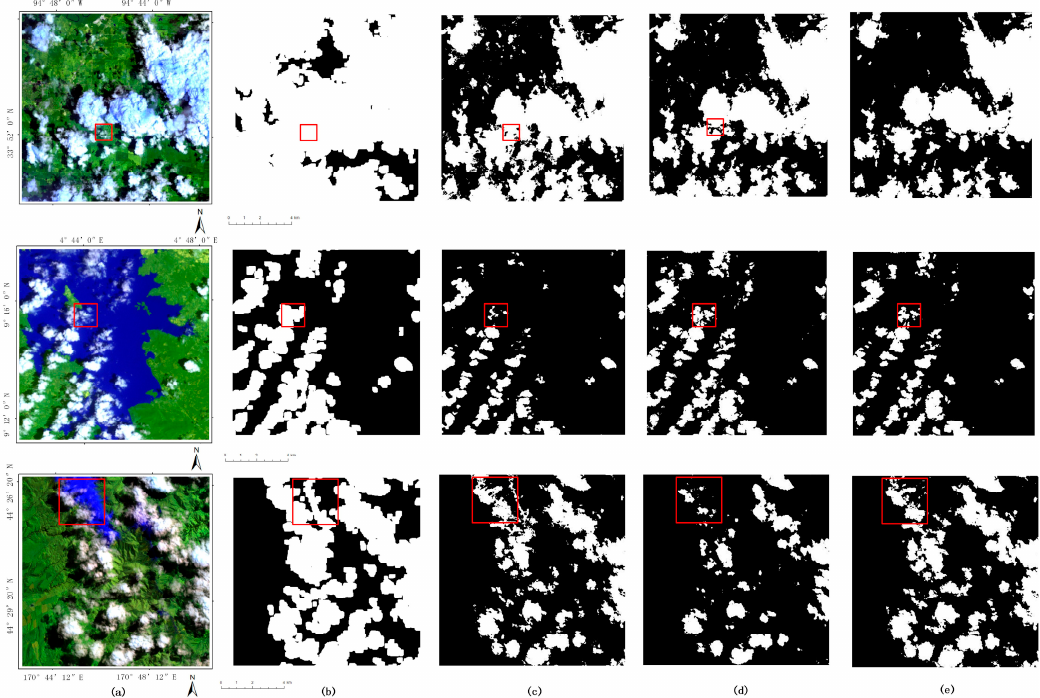
Figure 5. ( a ) Pseudo color Landsat ETM+ image with Band 4 as red, Band 3 as green, and Band 2 as blue. Cloud detection results with: Fmaks ( b ); SVM ( c ); RF ( d ); and our proposed approach ( e ).